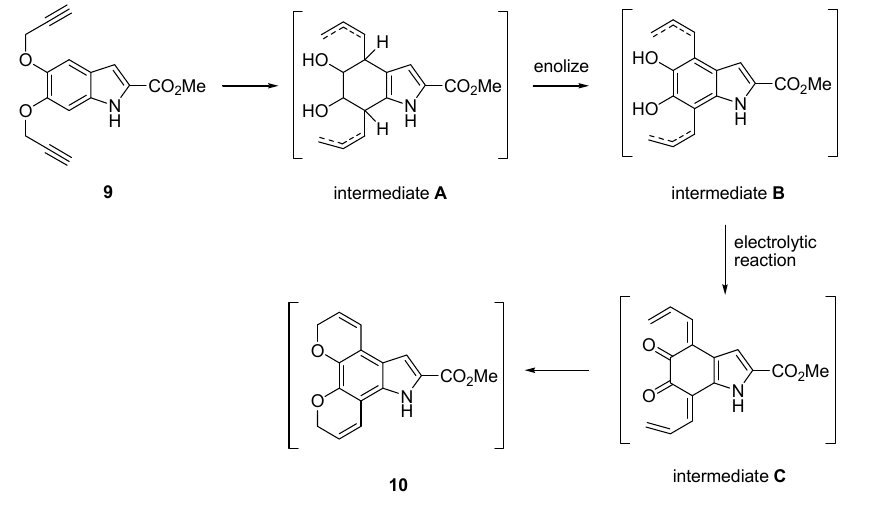
Figure 3. Possible reaction mechanism.